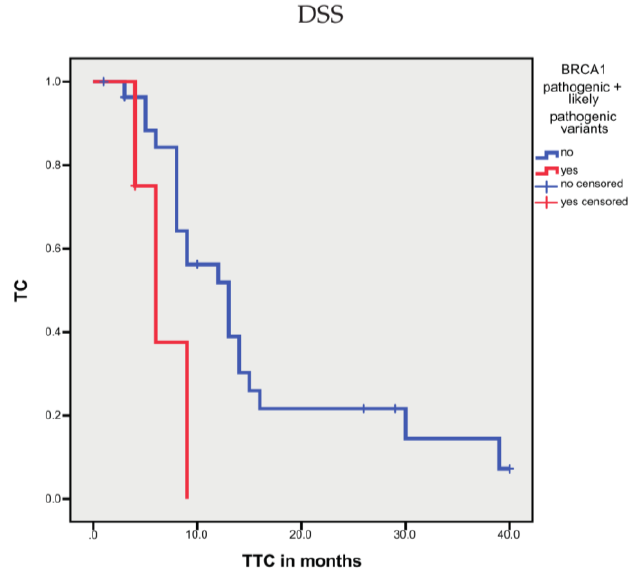
Figure 3. Kaplan – Meier analysis: association between BRCA1 sequence variants and time to treatment change (TTC). Patients with BRCA1 likely pathogenic and pathogenic sequence variants showed a shorter TTC ( p = 0.029).